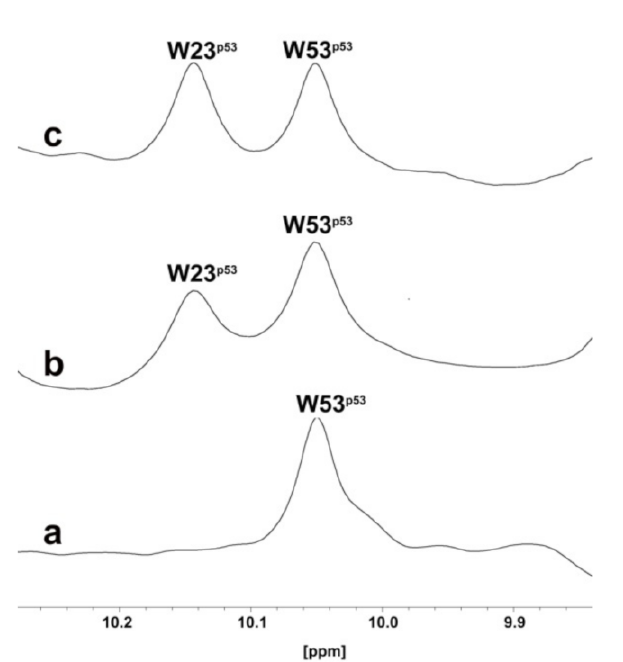
Figure 3. One-dimensional proton spectrum of side chains of tryptophans (W) of p53–MDM2 complex ( a ), p53–MDM2 complex after addition of RM37 ( b ), or Nutlin-3a ( c